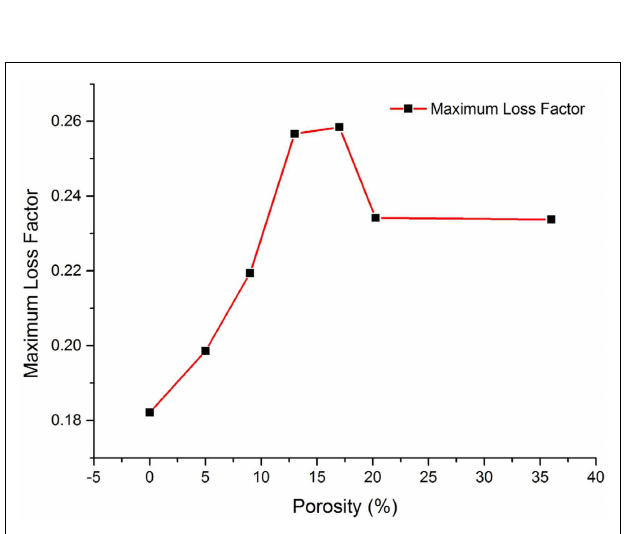
FIGURE 9 | Loss factor of MRE samples under different magnetic fields .